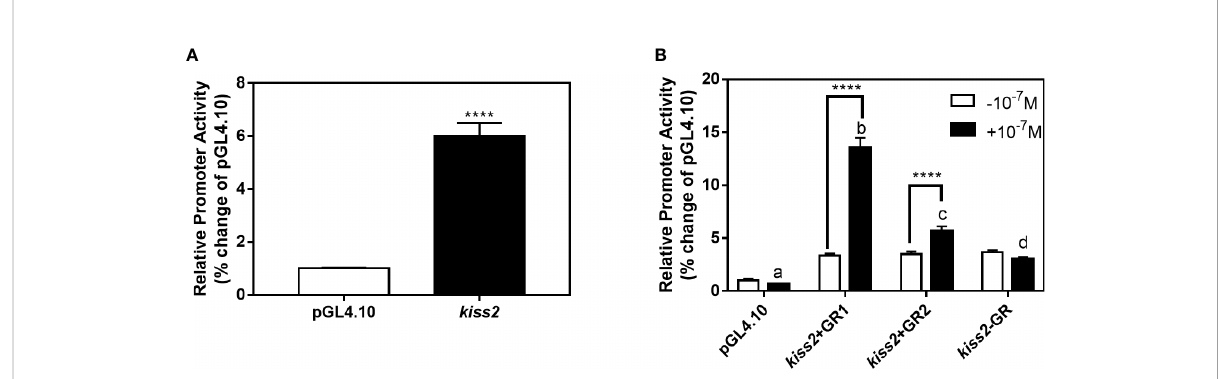
FIGURE 5 Effects of cortisol on kiss2 promoter activity. (A) Basic activity of kiss2 gene promoter in HEK-293T cell lines. The cells were transfected with 0.5 m g pkiss2-1442 and 0.025 m g pRL-CMV, or 0.5 m g pGL4.10 and 0.025 m g pRL-CMV as the control. Luciferase activity was measured after 24 h. Relative promoter activities are expressed as percentage of pGL4.10. (B) The activities of kiss2 promoter in the presence of cortisol in HEK293T cell lines. Cells were co-transfected with 0.5 m g pkiss2-1442, and 0.025 m g pRL-CMV with or without 0.05 m g yellowtail clown fi sh glucocorticoid receptor (GR1 or GR2) expression plasmid. The transfected cells were treated with or without 10 − 7 M cortisol. The luciferase activity was measured 24 h later. Relative promoter activities are expressed as percentage of pGL4.10 in the absence of cortisol. Data are represented as mean ± SEM (n = 4). **** (p < 0.0001) indicates that signi fi cant difference compared with the corresponding control. The different letters mean signi fi cant differences between groups with cortisol treatment (p <